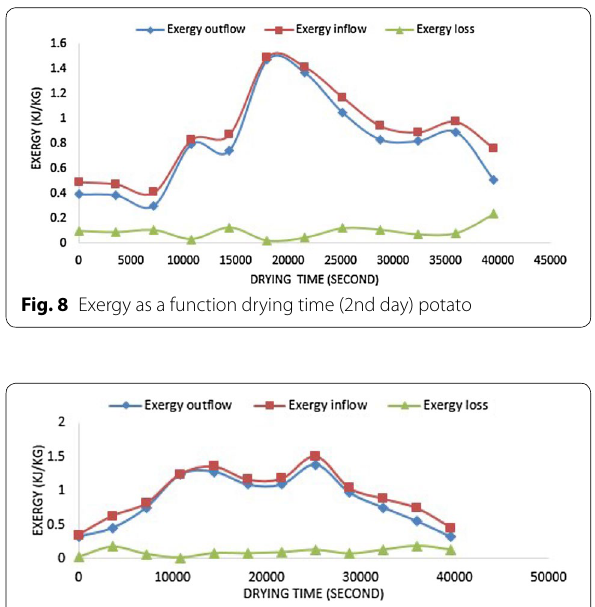
Fig. 5 Exergy as a function of drying time (2nd day) tomato